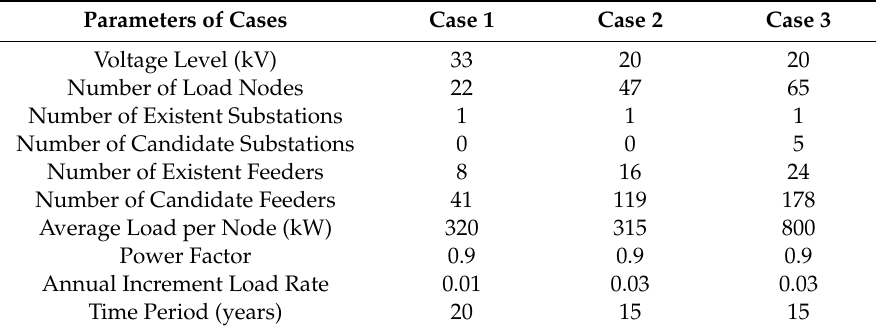
Table 2. Information of three cases for numerical studies.